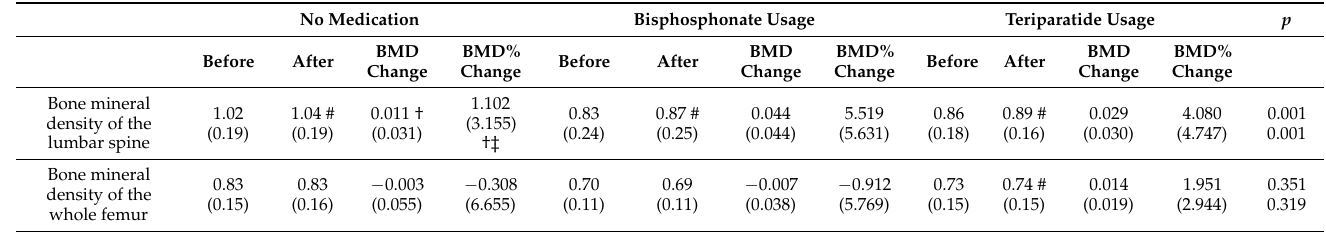
Table 2. The change of bone mineral density or trabecular bone